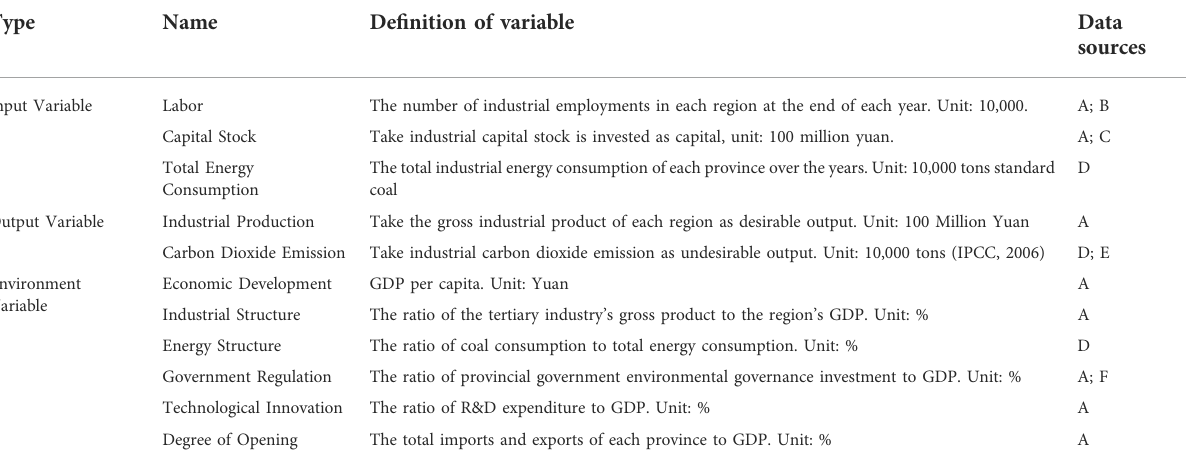
TABLE 1 The measurement index system of industrial energy carbon emissions dynamic ef fi